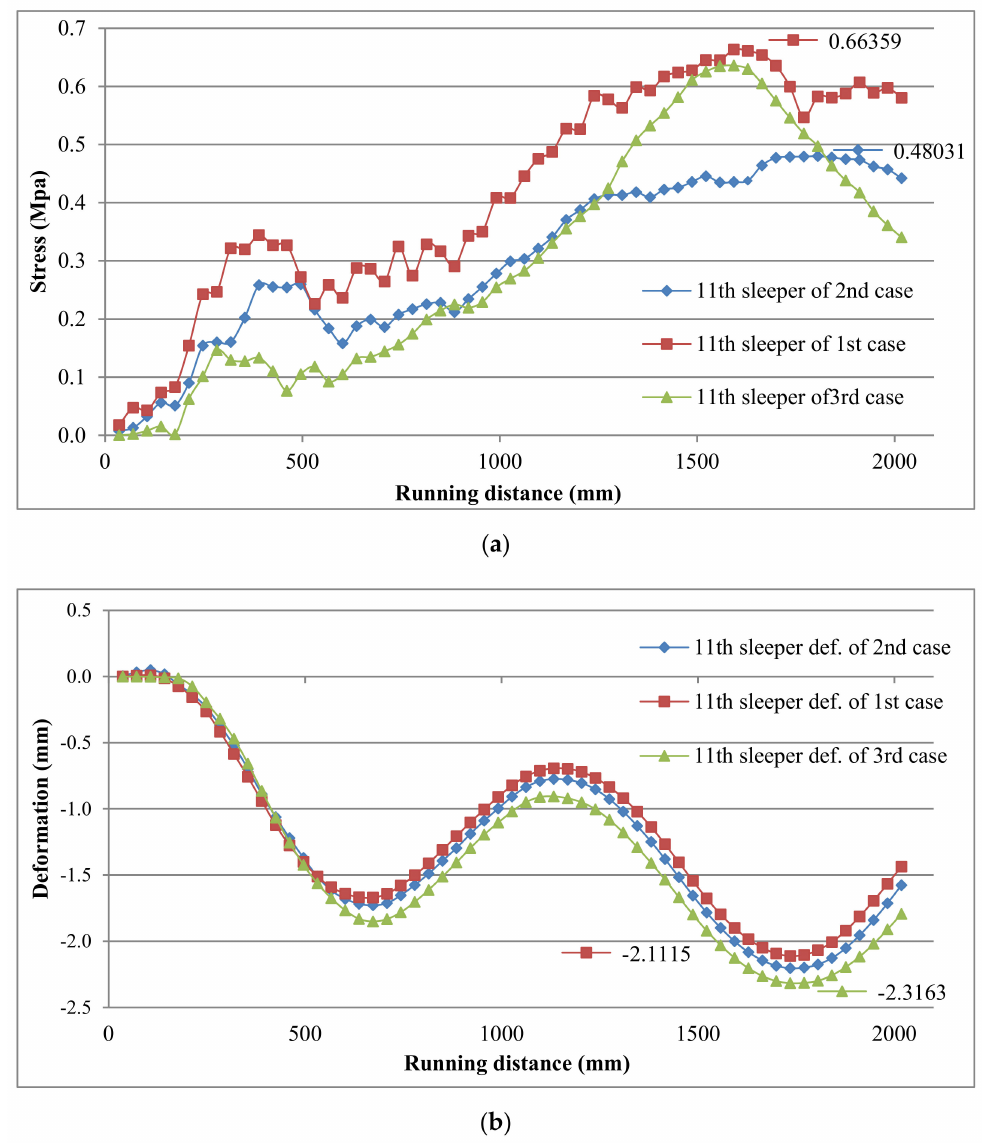
Figure 14. The 11th sleeper: ( a ) stresses; ( b )